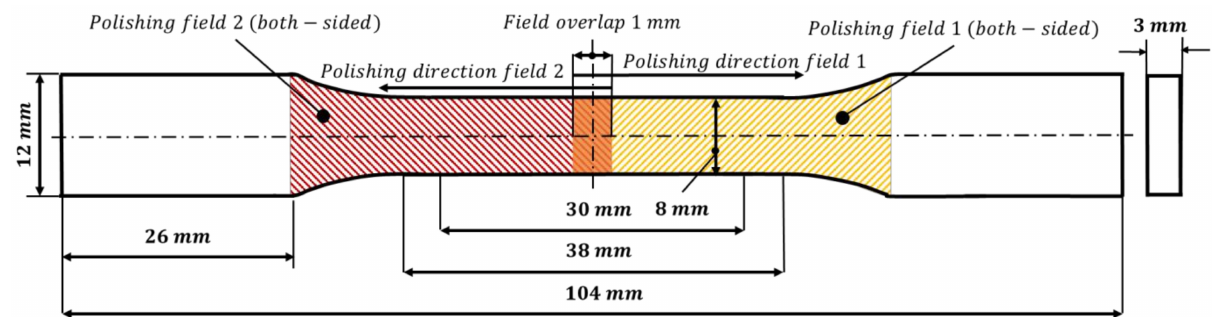
Figure 2. Geometry of the flat tensile specimens and definition of the polishing area with two sections and a field overlap of 1 mm.